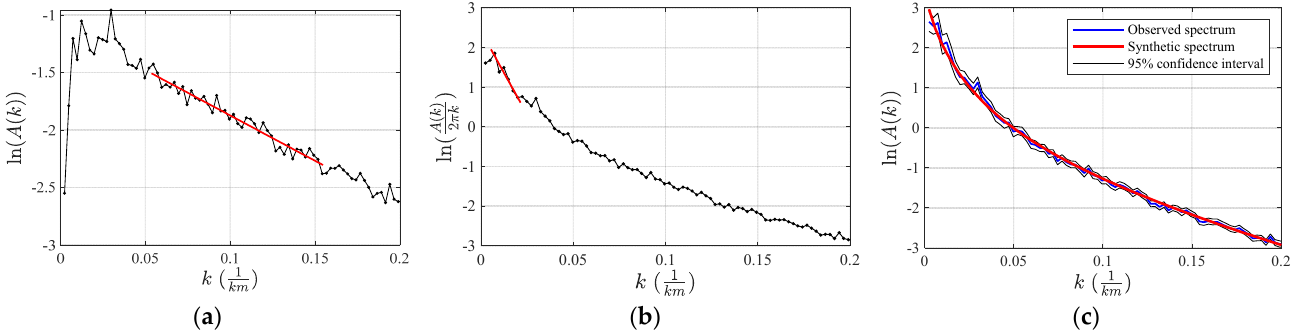
Figure 4. The dividing the wave number range and determination of the fractal parameters, using window 3 as an example, according to the fitted curve. The ( a ) selected high wavenumber range; ( b ) selected low wavenumber range; and ( c ) degree of fit between the observed power spectrum and the simulated power spectrum.